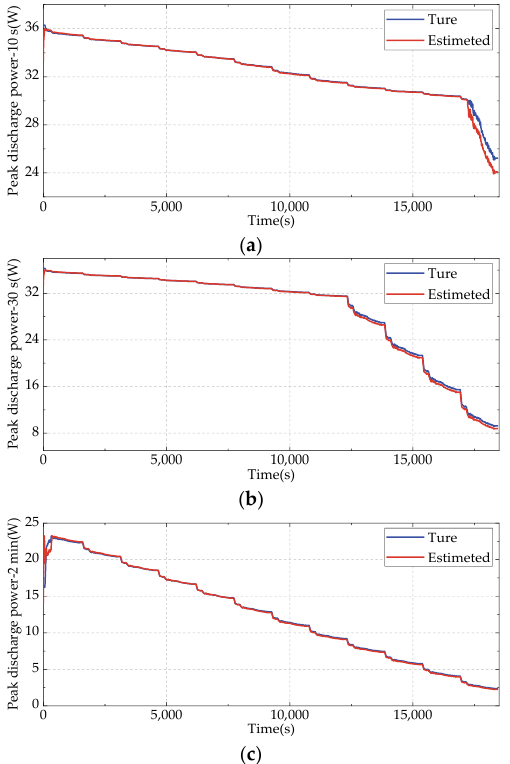
Figures 15 and 16 show the sustained peak discharge power curves and the corre- sponding error results for 10 s, 30 s, and 2 min of sustained discharge. In the initial stage of estimation, the sustained peak discharge power error is large. This is because there is an error between the initial estimate of the H∞ algorithm and the true value, and as the difference in the estimated end voltages increases, there is an increase in the error of sus- tained peak discharge power. Therefore, increasing the convergence speed of the SOC es- timation algorithm is conducive to reducing the sustained peak discharge power estima- tion error. In addition, the longer the duration of continuous discharge, the lower the con- tinuous peak discharge power at the same moment. This is because the sustained peak discharge power decreases when the current of sustained discharge decreases with the extension of discharge time under multiple constraints. According to the results listed in Figure 14. Results of peak discharge current estimation in different time scales: ( a ) 10 s; ( b ) 30 s; ( c ) 2 min. Table 1, the peak discharge power MARE is less than 1.5% and the RMSE is less than 1.5 W at different sustained discharge times.